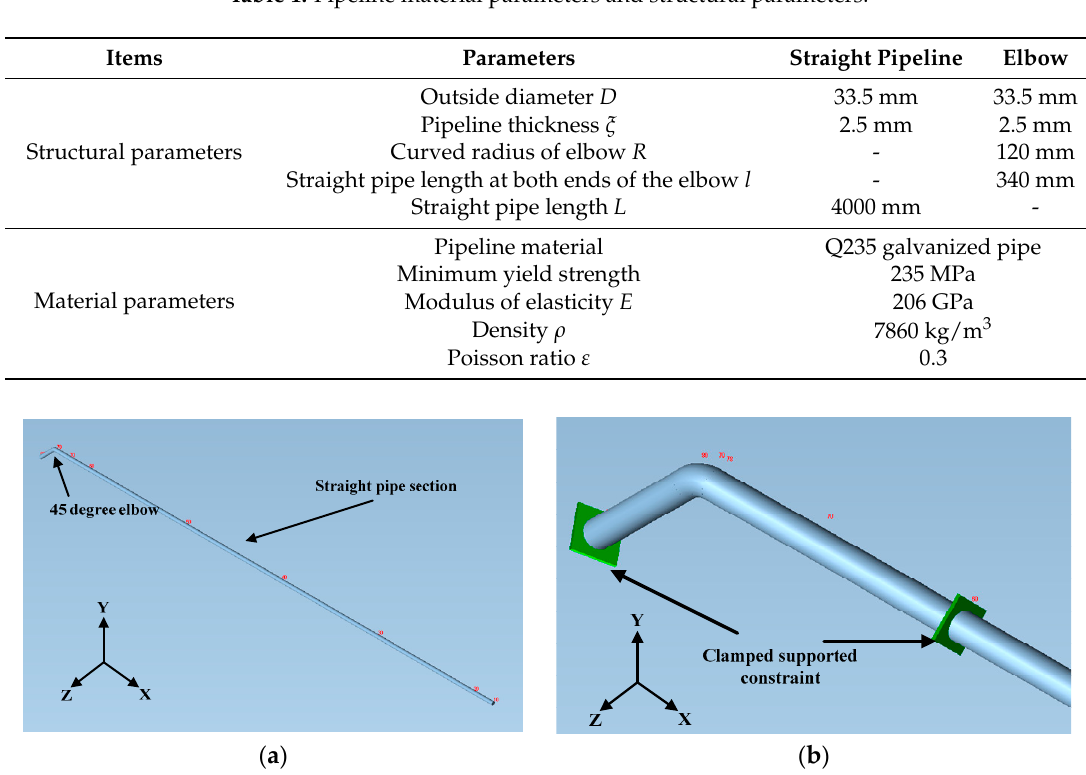
Figure 4. Pipeline foundation model and constraint model of the simple pipe established by CAESAR II software: ( a ) overall model; ( b ) constraints’ model.